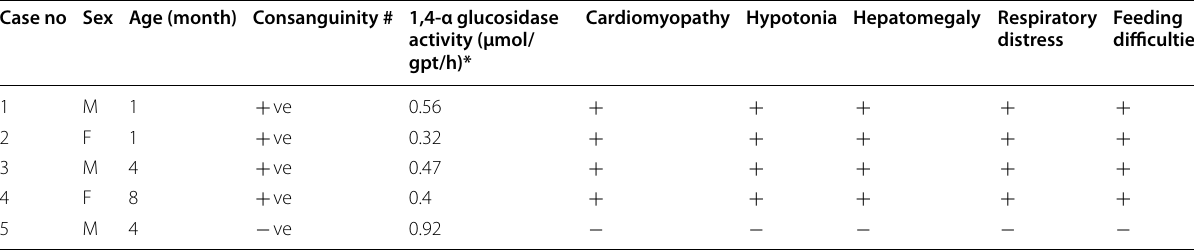
Table 2 Enzyme activity and main clinical features in the studied subjects